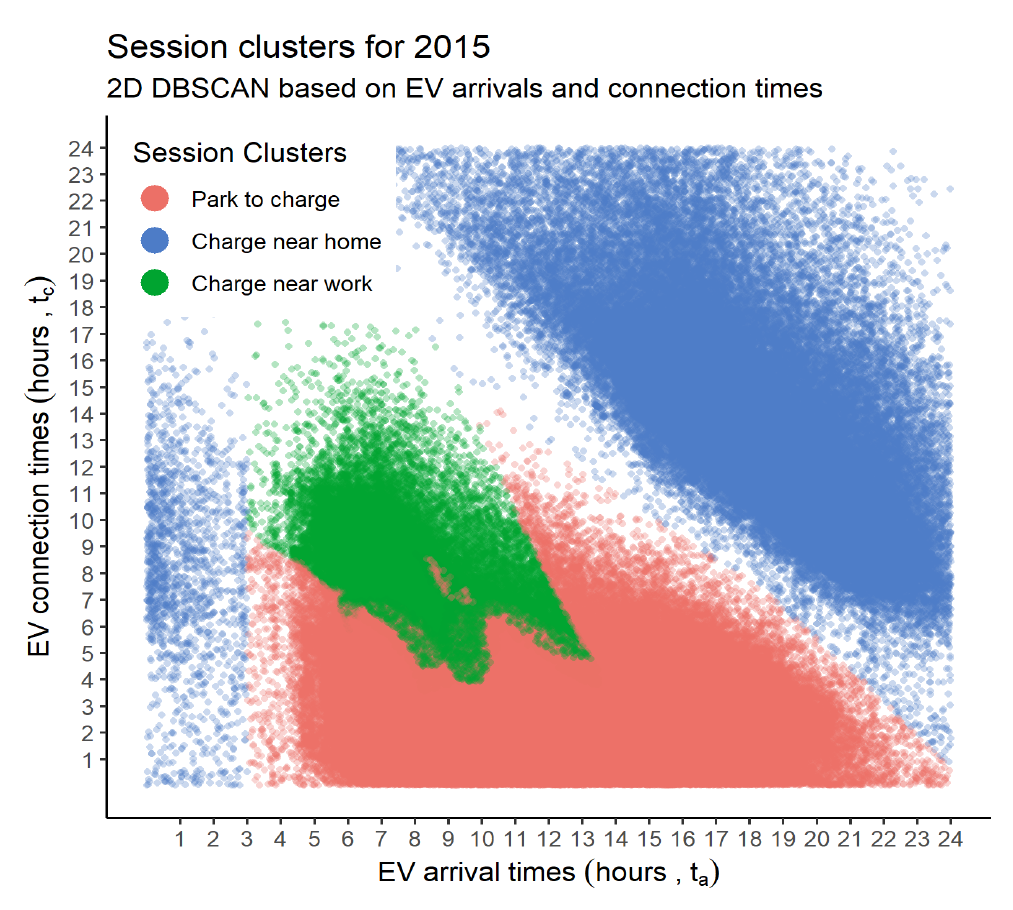
Figure 3. Session clusters for 2015. We used DBScan to cluster EV sessions on a monthly basis, and combine the data for all